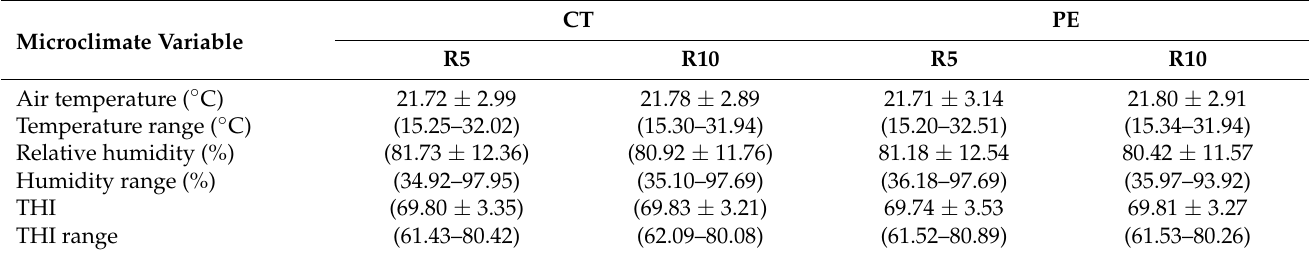
Table 2. Microclimate variable (mean ± standard deviation) and range (min—max) by